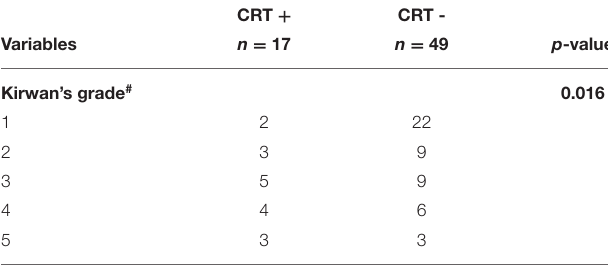
TABLE 7 | Anorectal function for patients who underwent total ISR. CRT + CRT - Variables n = 17 n = 49 p